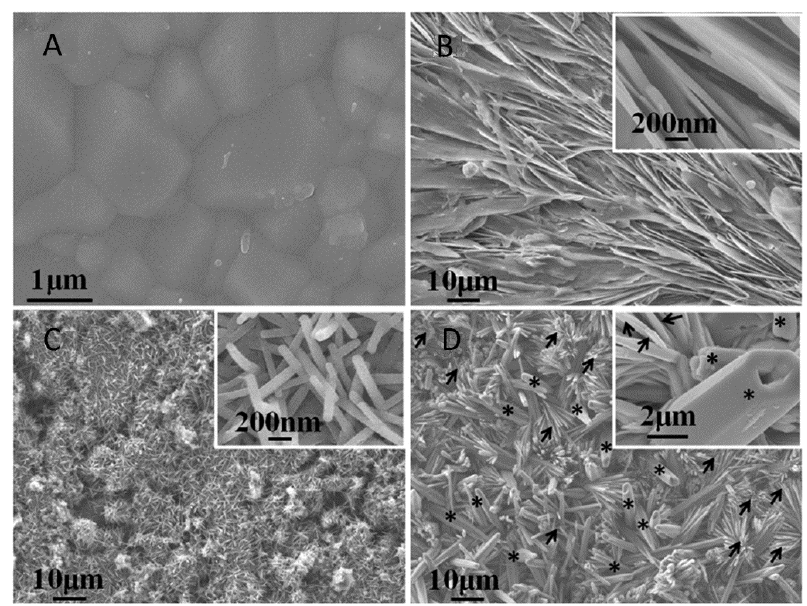
Figure 3. Difference in surface topography of standard TCP ( A ) when compared to biomimetic surfaces with variable topography; nanosheet ( B ), nanorod ( C ), and micro–nanohybrid ( D ). Reprinted from [39] with permission from ACS.